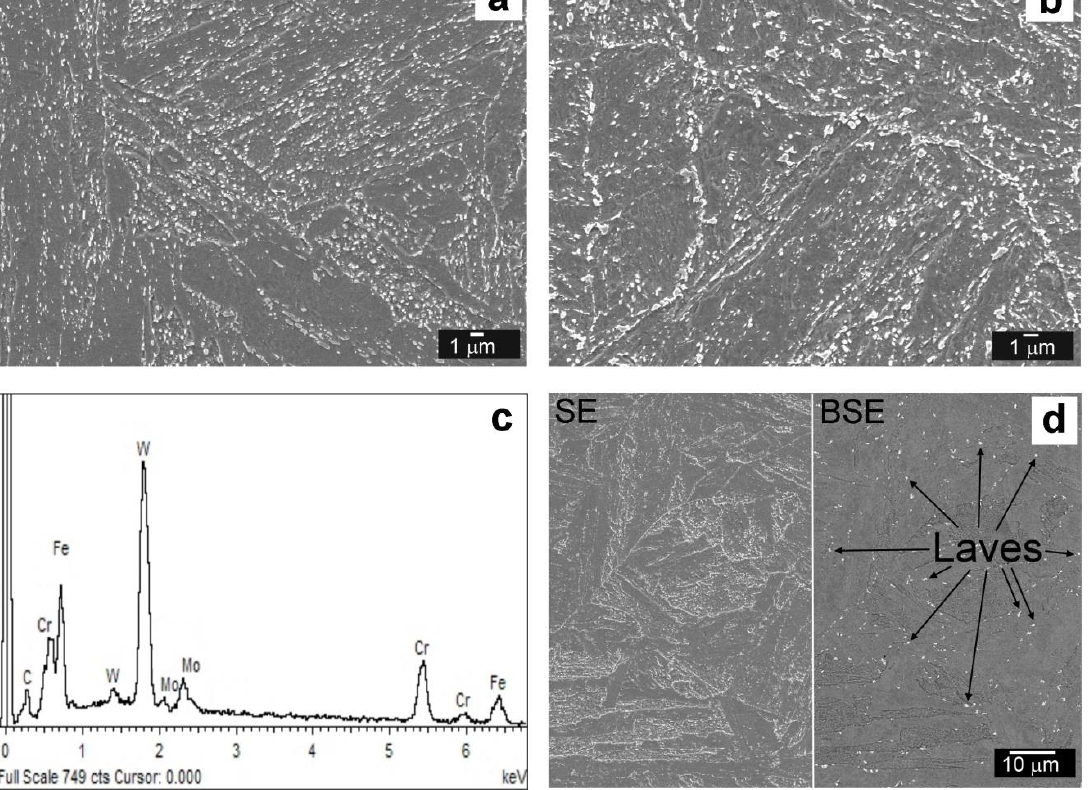
Figure 4. Microstructure of the Ni weld metal (WM) (Thermanit Nicro 82) region, states: QT PWHT ( a ); QT PWHT + 620 °C/2500 h ( b ).